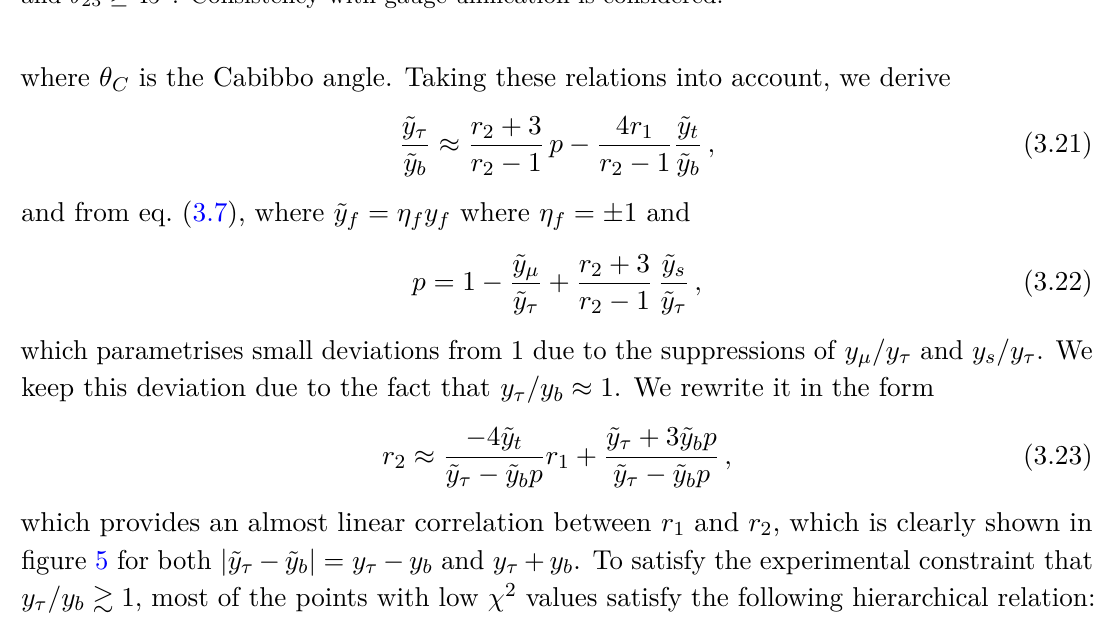
Figure 5 . The predicted observables (top left two panels), the effective neutrino mass prediction (top right panel) and two-dimensional correlations between theory inputs (bottom panels) for χ 2 < 10 and θ 45 ◦ . Consistency with gauge unification is 23 ≥